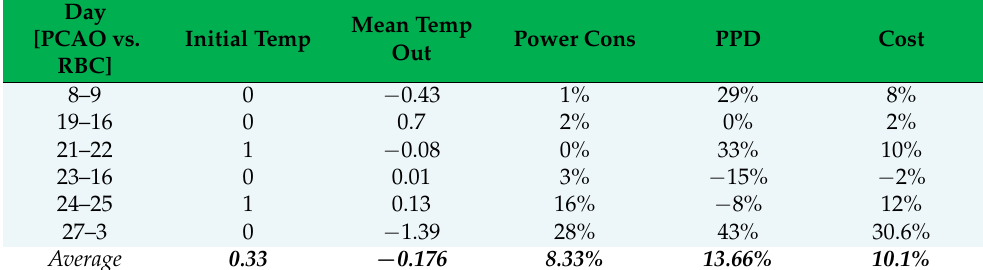
Table 17. Overall aggregated comparison of results